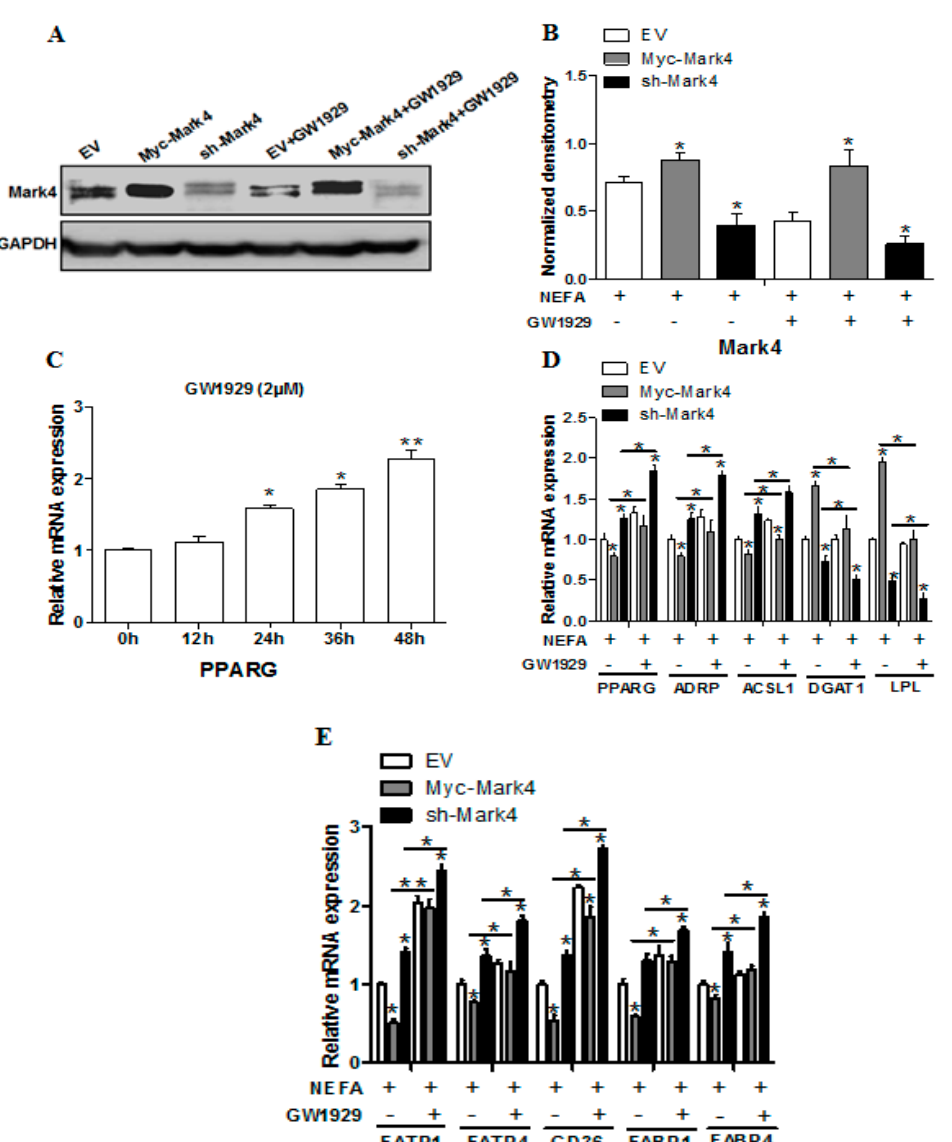
Figure 3. Effects of MARK4 on key molecules of lipid metabolism in pig primary trophoblast cells. ( A – B ) Representative immunoblots and densitometric quantification for MARK4 after transfection with Myc-MARK4, sh-MARK4 for 48 h in primary trophoblast cells isolated from pig placentas. Cells were then incubated with 400 µ M NEFA or 2 µ M GW1929 for 24 h ( n = 3). ( C ) Primary trophoblasts were cultured and incubated for 0 h, 12 h, 24 h, 36 h and 48 h in the presence of 2 µ M GW1929. Relative mRNA expression of PPAR γ was detected ( n = 3). ( D – E ) Relative mRNA expression of lipid metabolism-related genes ( D ) and fatty acid (FA) transporters ( E ) after transfection with Myc-MARK4, sh-MARK4 for 48 h in primary (trophoblast cells). Cells were then treated with 400 µ M NEFA or 2 µ M GW1929 for 24 h ( n = 3). Values are expressed as mean ± SEM. ** p < 0.01; * p < 0.05 compared with the control group. Myc-MARK4 group: over expression of MARK4 group, sh-MARK4 group: knock down of MARK4 group, Control: empty vector (EV)